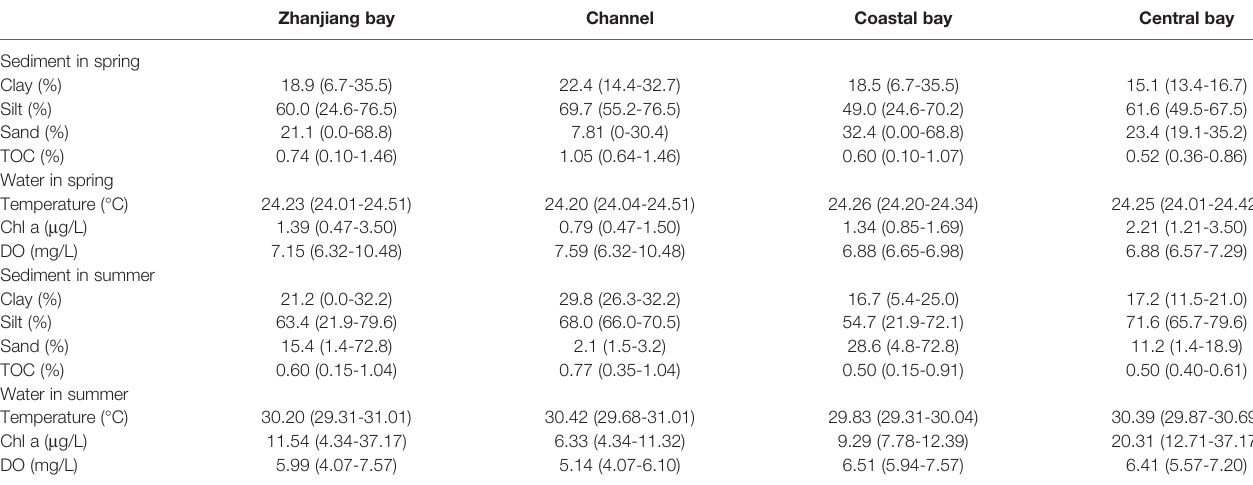
TABLE 1 | Average (minimum-maximum) of surface sediment and bottom water parameters in Zhanjiang bay in spring and